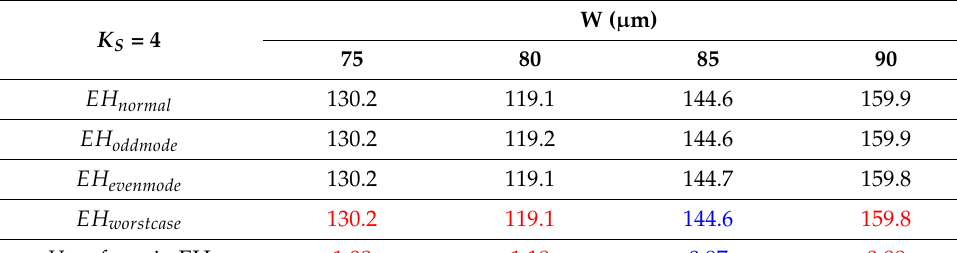
Table 7. Eye diagram simulation against W in the stripline structure.